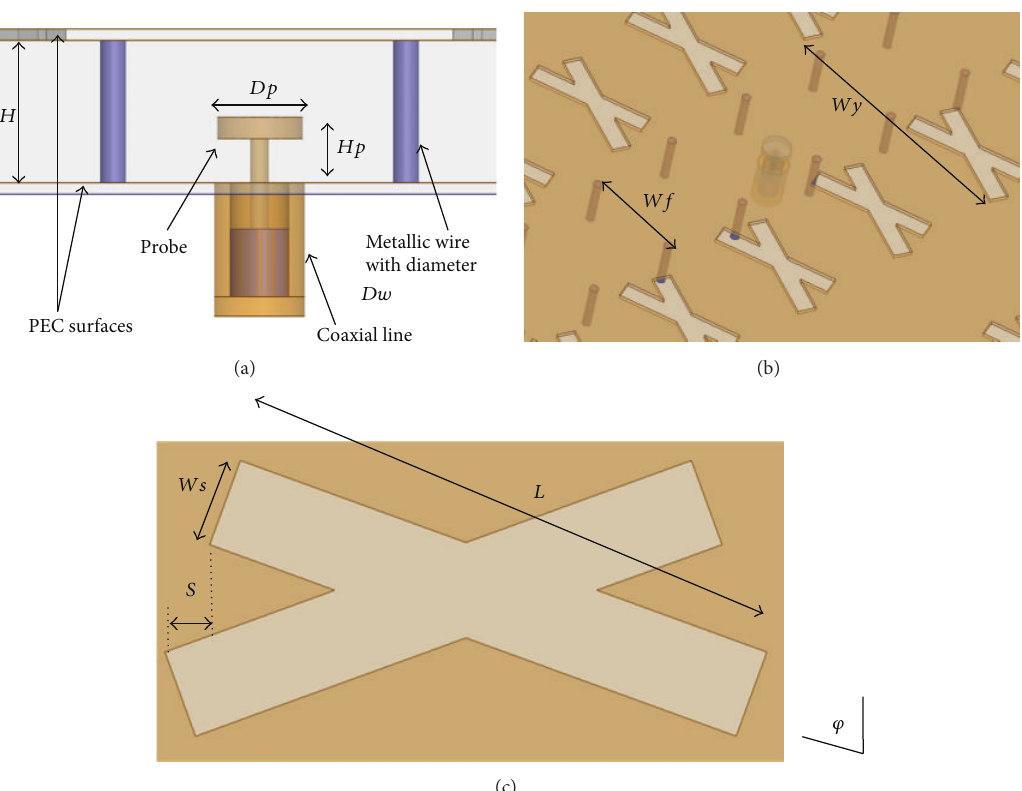
Figure 2: Details of the proposed antenna: (a) probe excitation; (b) Fabry-Perot cavity and position of cross-slots; (c) cross-slot design details.